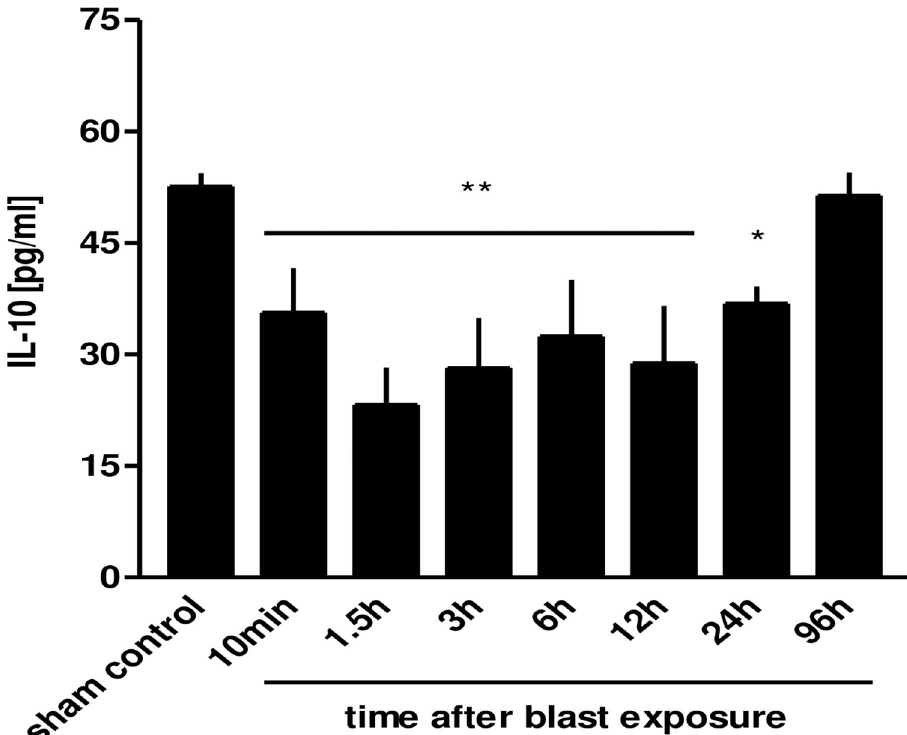
Fig 9. Decrease in BAL IL-10 after thoracic trauma. The animals were sacrificed 10 min (n = 6), 1.5 h (n = 3), 3 h (n = 3), 6 h (n = 3), 12 h (n = 4), 24 h (n = 3) or 96 hours (n = 3) after blast exposure, non-traumatized animals served as sham controls (n = 9). IL-10 release was assessed in BALFs. Data were statistically analysed by one-way ANOVA and Dunnett’s multiple comparison test: � p < 0.05 and �� p < 0.01 vs. sham control. Data are means ± SEM, number of experiments (n) in